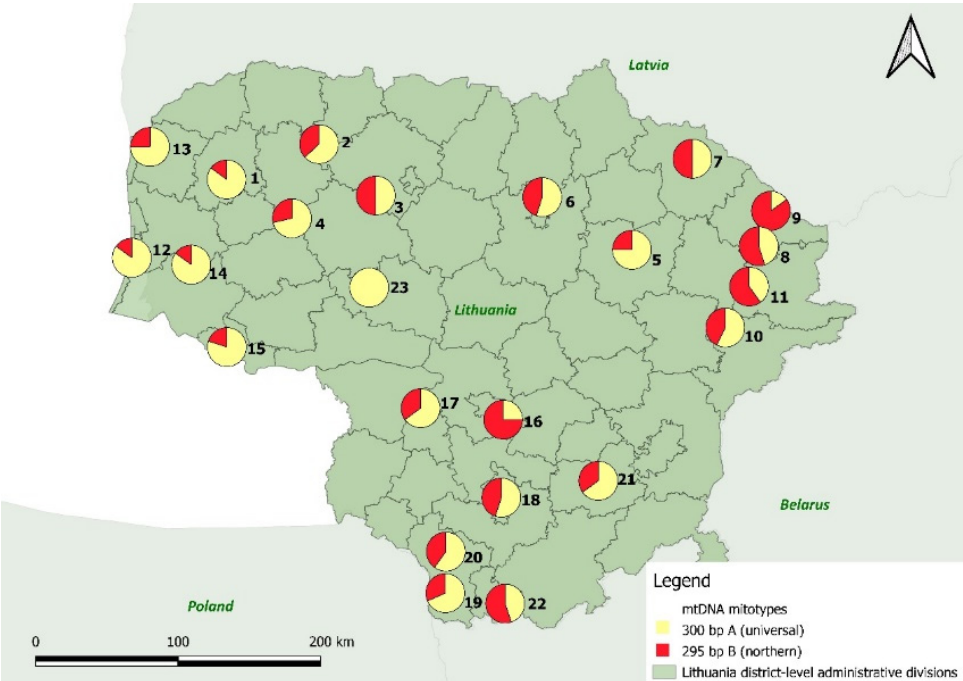
Figure 4. Geographical distribution of the mtDNA haplotypes (mitotypes) in natural Scots pine populations within Lithuania. The colors red and yellow correspond to the mitotypes A (universal, yellow) and B (northern, red). The size of the pie charts is proportional to the relative frequency of mitotypes.